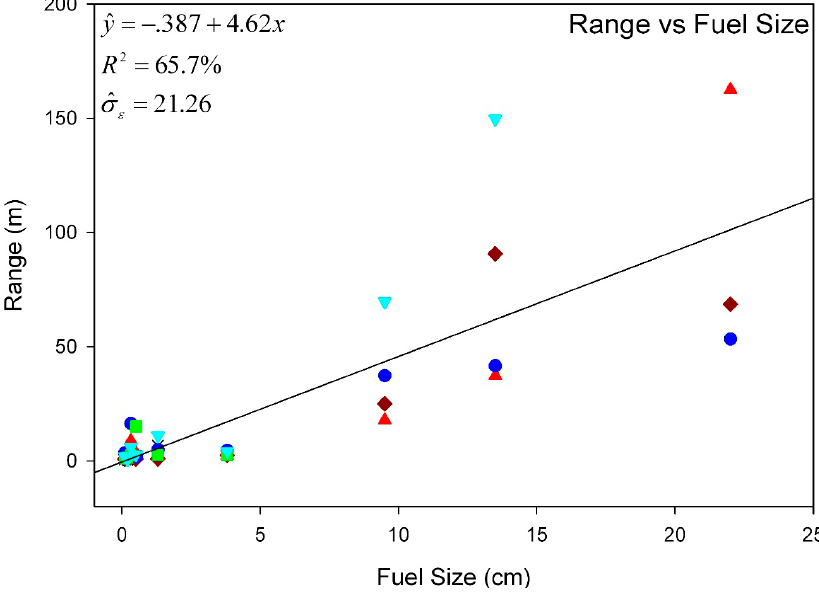
Figure 4. Relationship of semi-variogram range (m) with the size of fuel particle represented by diameter (cm).